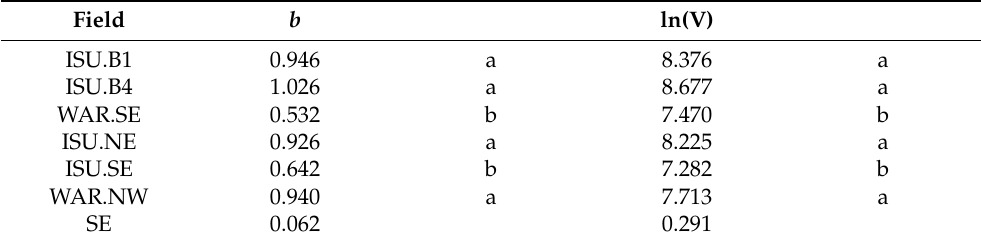
Table 2. Estimates of Smith’s soil heterogeneity index ( b ), the natural logarithm of the base variance (V) estimated using ln–ln linear regression of variance on plot area. Means within columns followed by the same letter were not significantly different at p = 0.05.